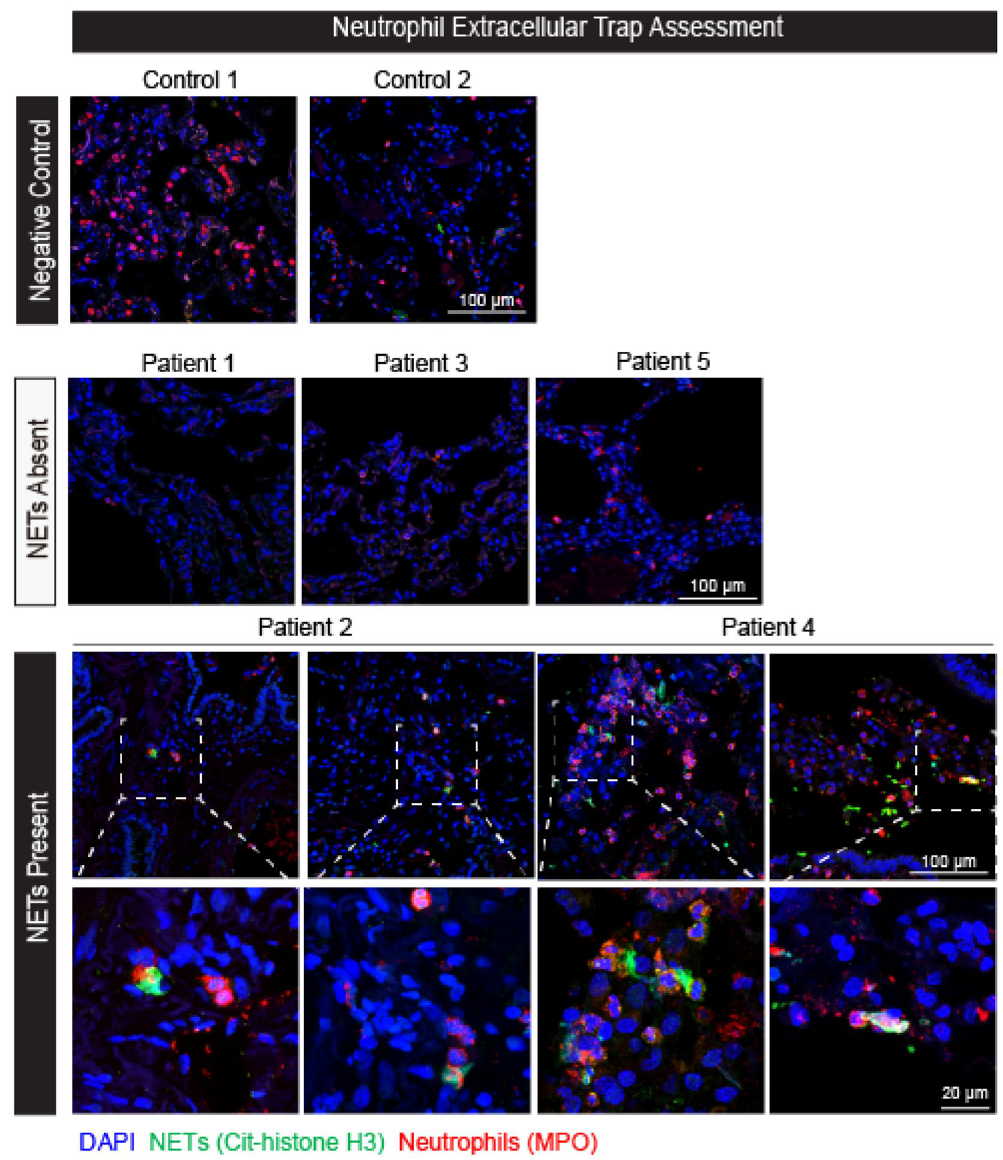
Figure 2. Representative confocal microscopy of lung parenchyma for Neutrophil Extracellular Traps (NETs) staining from the patient cohort with non-fibrosed controls, patients without NETs, and patients with NETs. NETs were indicated by immunofluorescent staining for myeloperoxidase (red), citrullinated histone H3 (green), and DAPI (blue). Top row (Negative Control): Imaging from the lung parenchyma from non-fibrosed controls; Scale bar, 100 μm. Middle row (NETs Absent) : Imaging from the lung parenchyma of patients 1, 3, and 5 with NETs absent; Scale bar, 100 μm. Bottom row (NETs Present): Higher-magnification images of the boxed areas of Patient 2 and 4 are shown at bottom row; scale bar, 20